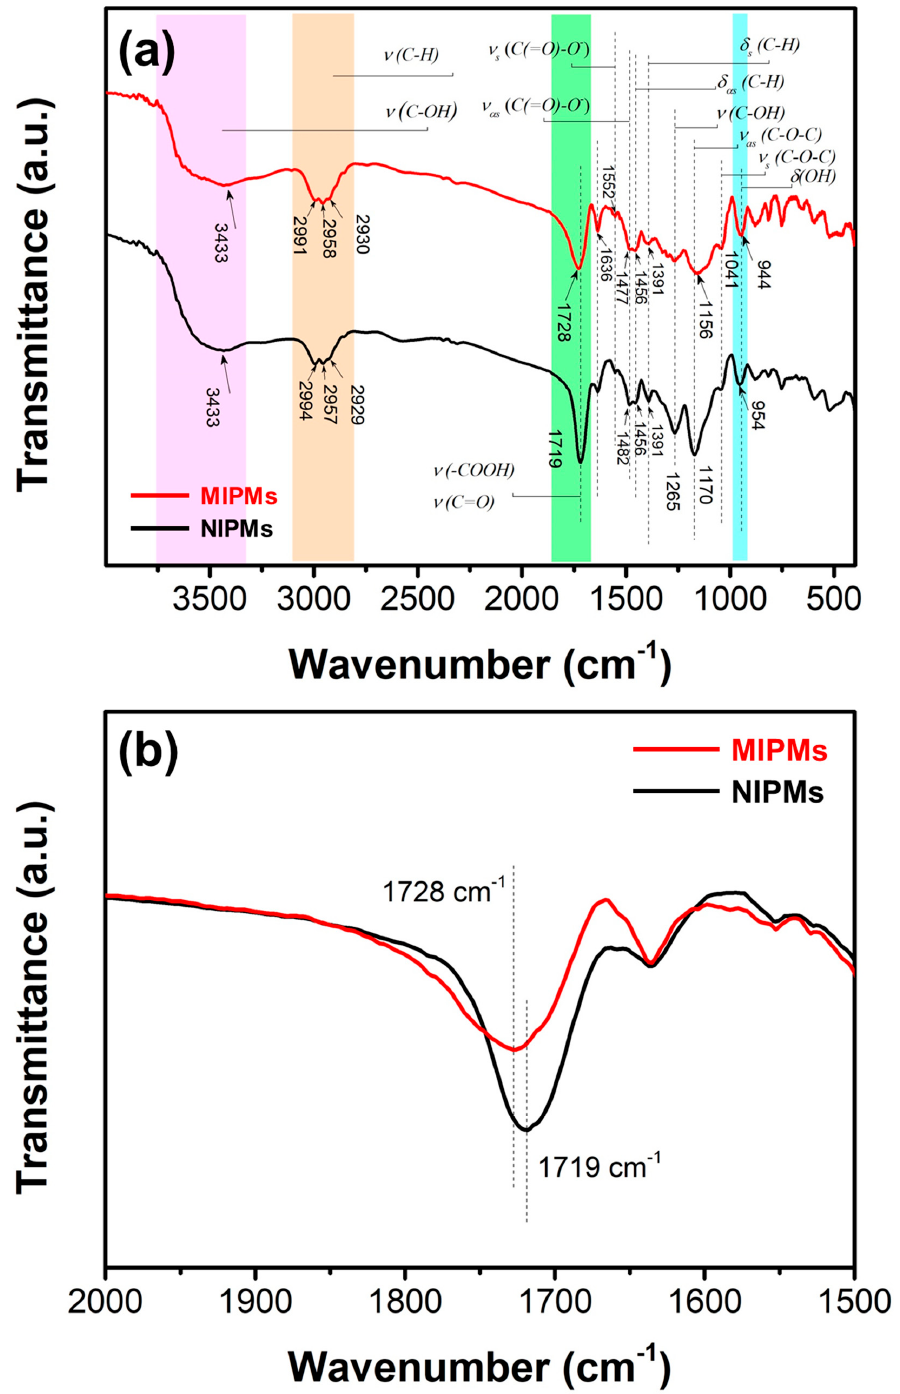
Figure 5. ( a , b ) FTIR spectra of the prepared NIPMs and MIPMs samples; the magnified FTIR spectra in the selected wavenumber range of 2000–1500 cm − 1 .